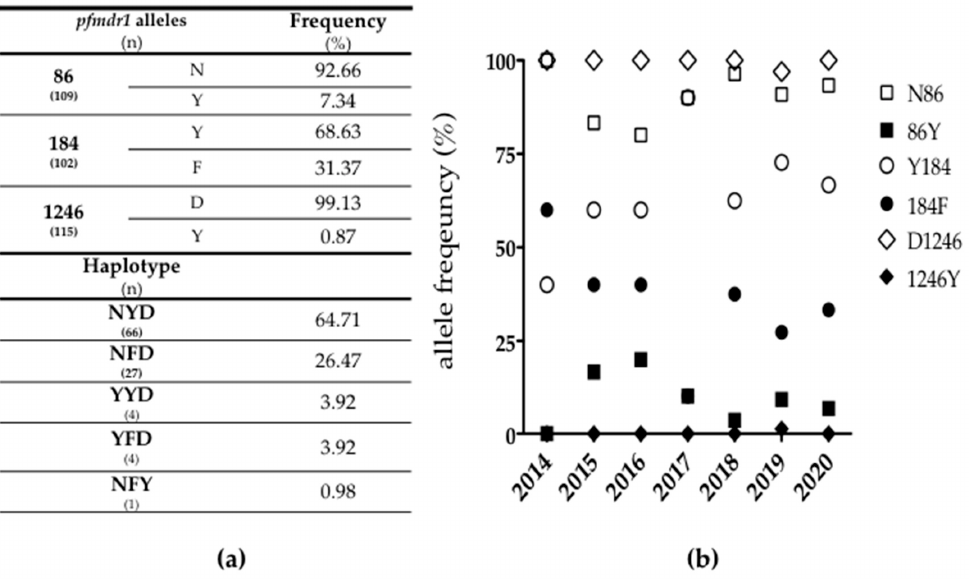
Figure 2. Molecular characterization of P. falciparum pfmdr1 gene in imported parasites to Portugal. ( a ) pfmdr1 allele and haplotype frequency; ( b ) Temporal trend in pfmdr1 allele frequency, open symbols correspond to the wild type and filled symbols mutant alleles. The two samples from 2021 are not included in the graphic, one was NFD and for the other the positions 86 and 184 were not successfully sequenced and 1246 was wild type.